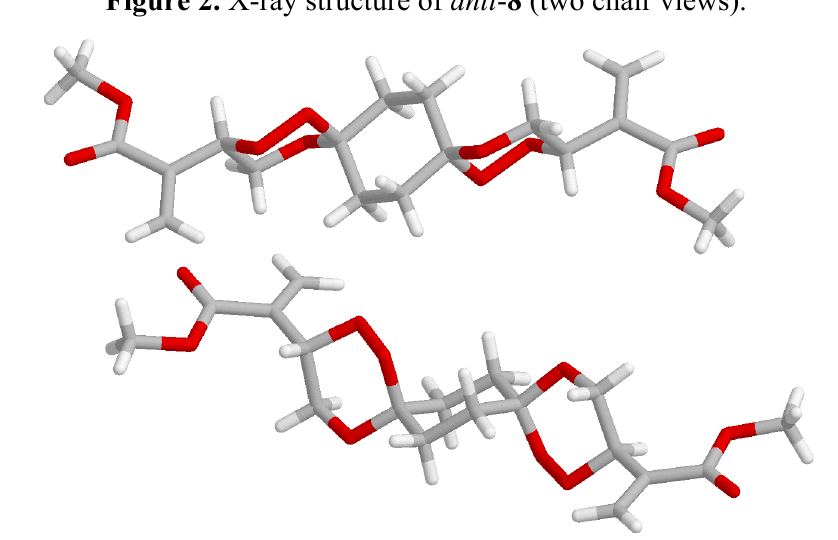
Figure 2. X-ray structure of anti - 8 (two chair views).